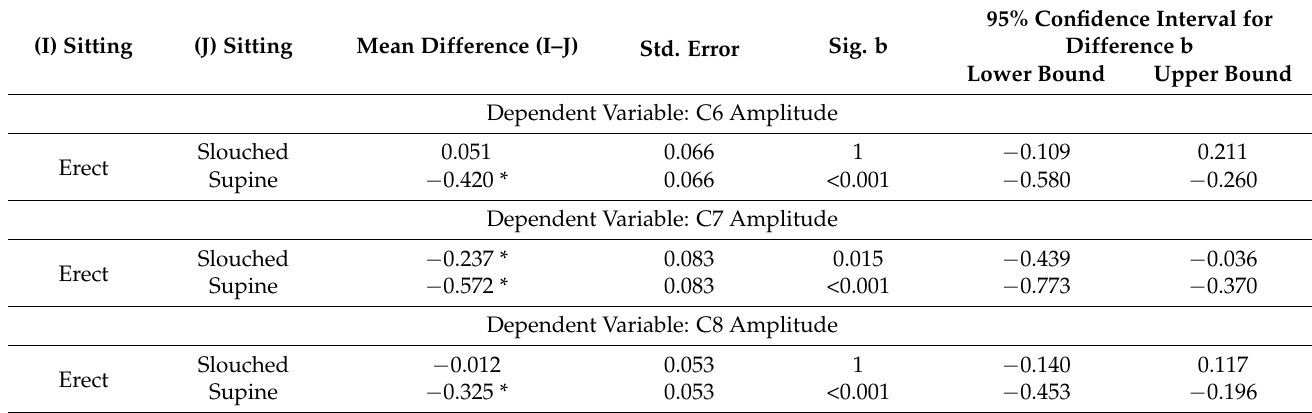
Table 4. Pairwise comparisons.